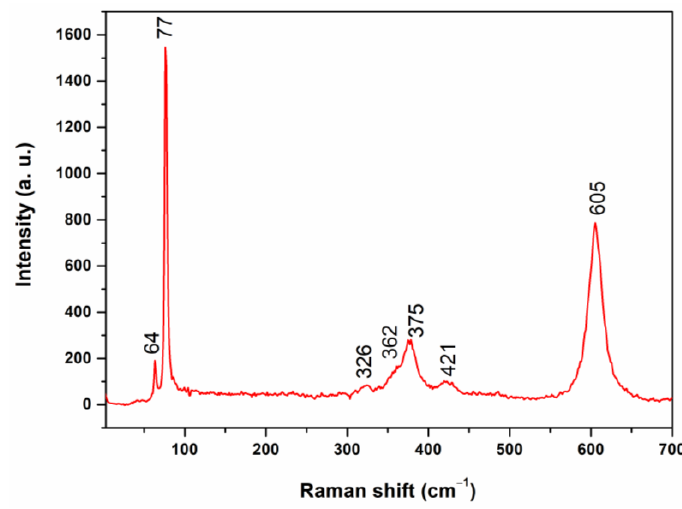
Figure 6. Raman spectrum of TbInO 3 crystal at room temperature.